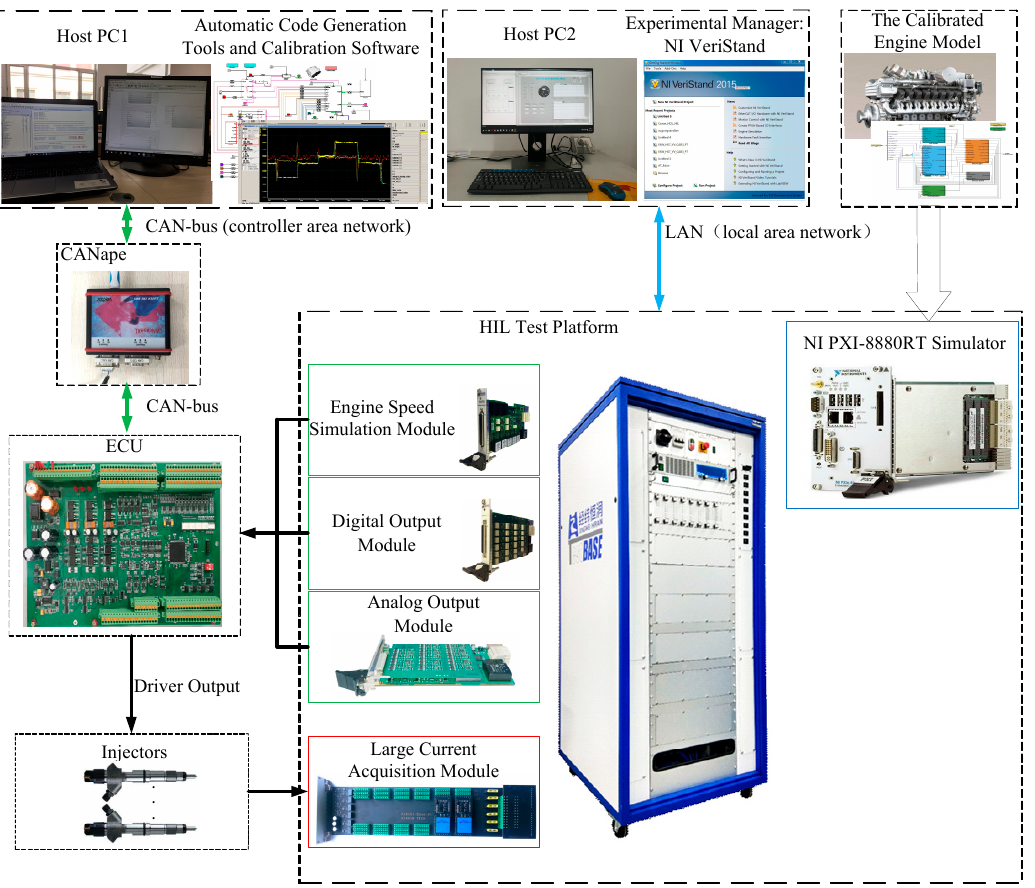
Figure 5. The experimental setup by using the Hardware-in-the-loop (HIL) test platform.